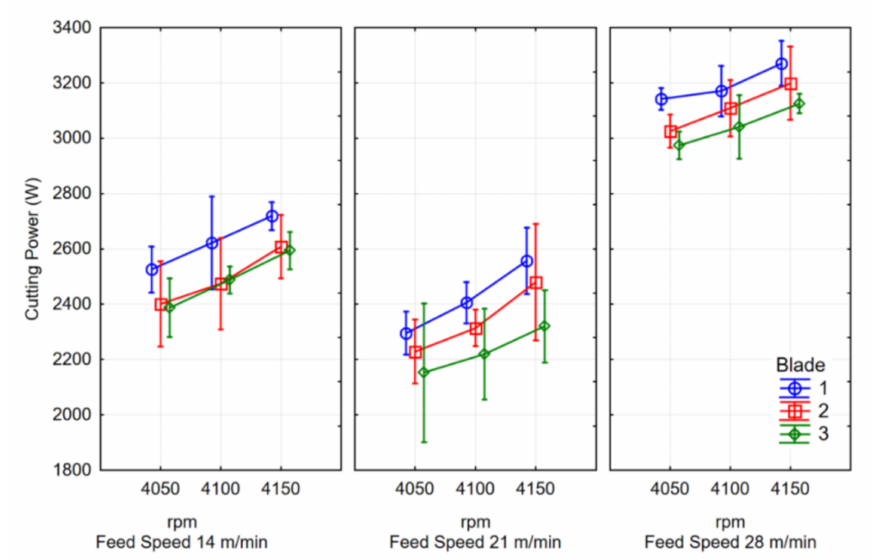
Figure 5. Effect of the rotation speed (rpm) and the design of the circular saw blades on the cut- ting power.